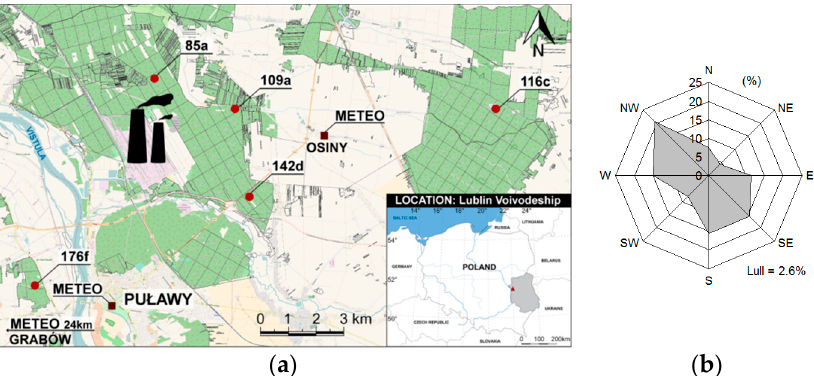
Figure 1. Location of dendroclimatological research (85a, 109a, 142d, 116c, 176f) in the area of Zakłady Azotowe Puławy, located in the Puławy Forest District (central and eastern Poland) ( a ), wind rose constructed on the basis of data from meteorological stations (METEO): Puławy, Osiny and Grabów for the years 1951–2013 ( b ).